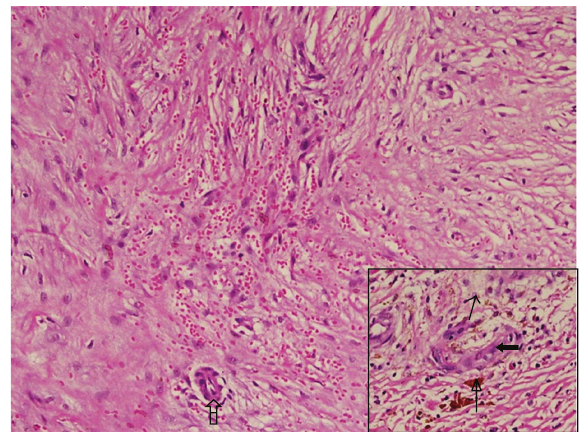
Figure 1: 400x; histopathology showing thick-walled capillaries (closed arrow in inset and open arrow in main figure), hemosiderin deposition with golden brown color (arrow in inset), and sparse perivascular lymphocytic infiltrate (thin arrow in inset).